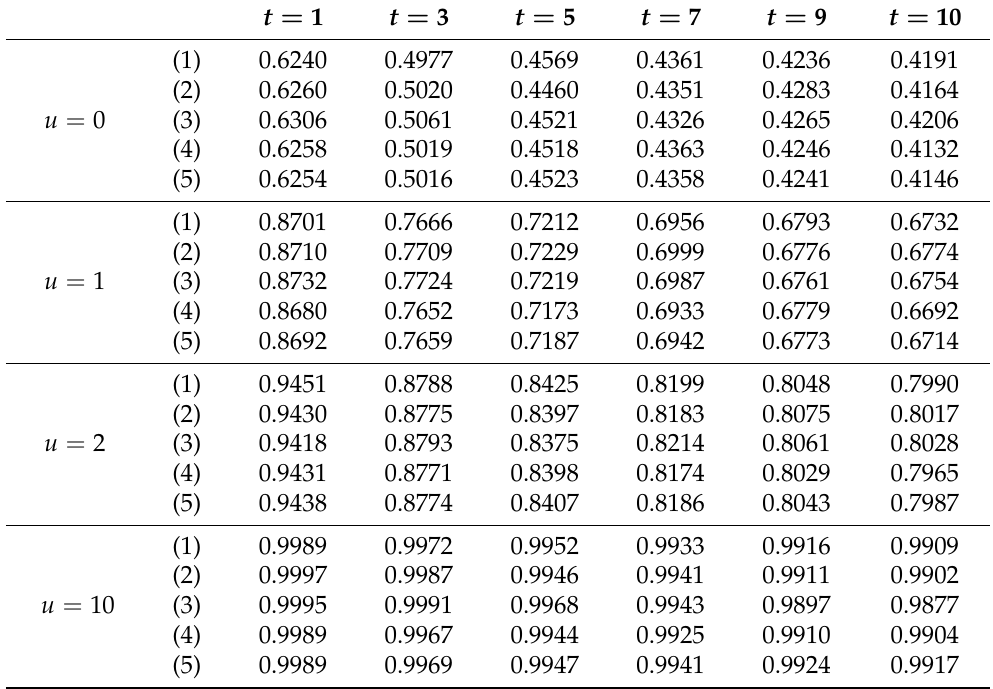
Figure 7. The DNN approximation solution with a Pareto distribution (the times of training: 50,000). Table 2. Approximated finite-time survival probabilities with Pareto claim size for different time horizons ( t = 1,3,5,7,9,10 ) with various initial reserves ( u = 0,1,2,10 )